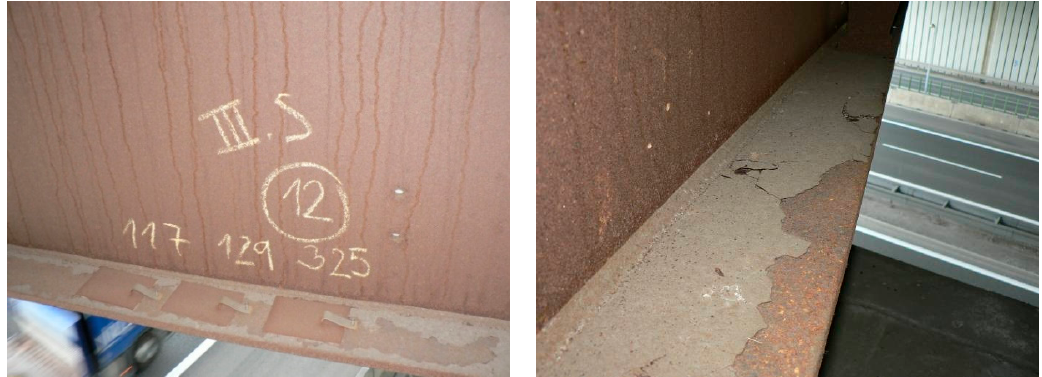
Figure 8. Bridge No. 1—unfavorable development of corrosion products on the internal upper surface of the bottom flange (surface P6). of the bottom flange (surface